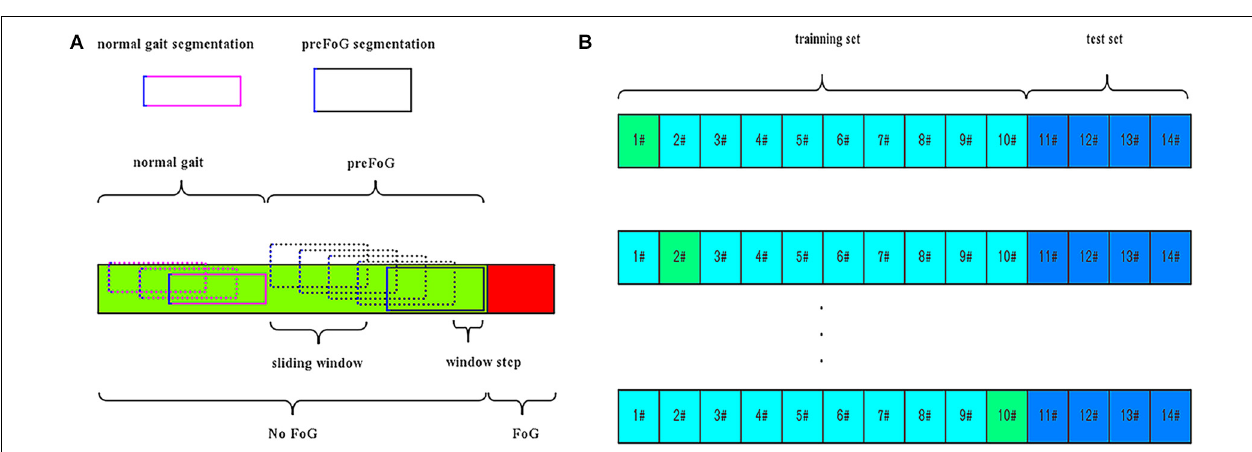
FIGURE 3 | (A) Segmentation and pre-freezing of gait (preFOG) labeling. (B) Example of the training and evaluation data. In total, 10 patients’ data were used in training and 10-fold cross-validation, and four patients’ data were used in